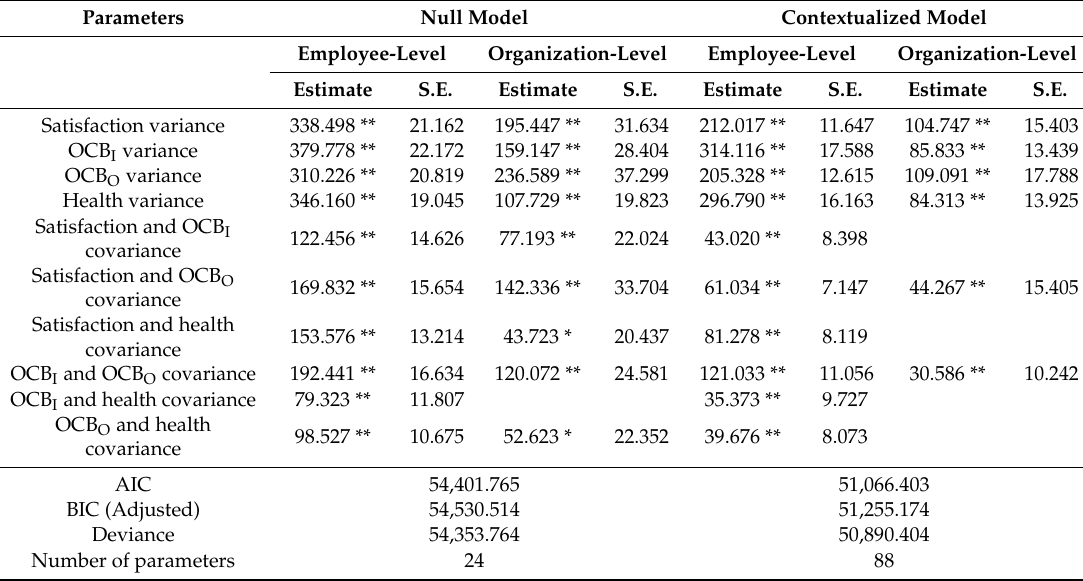
Table 4. Random part of the null model and the contextualized